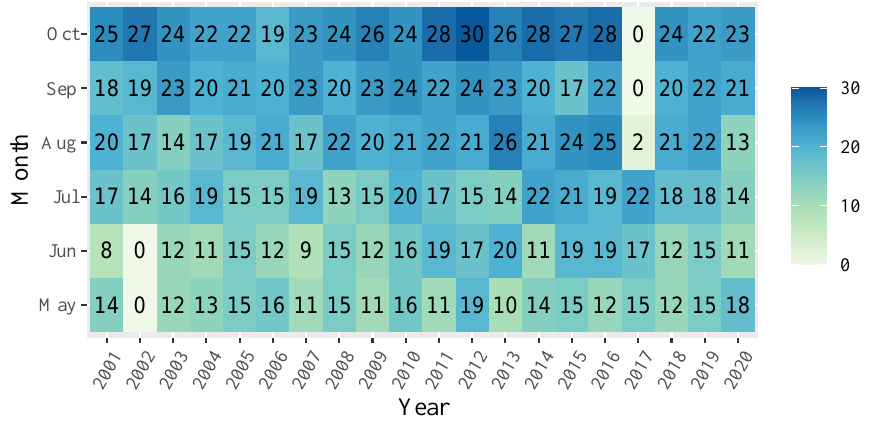
Figure 2. Heatmap of the data distribution in each month during the whole study period (value in each cell indicates the number of images within the corresponding